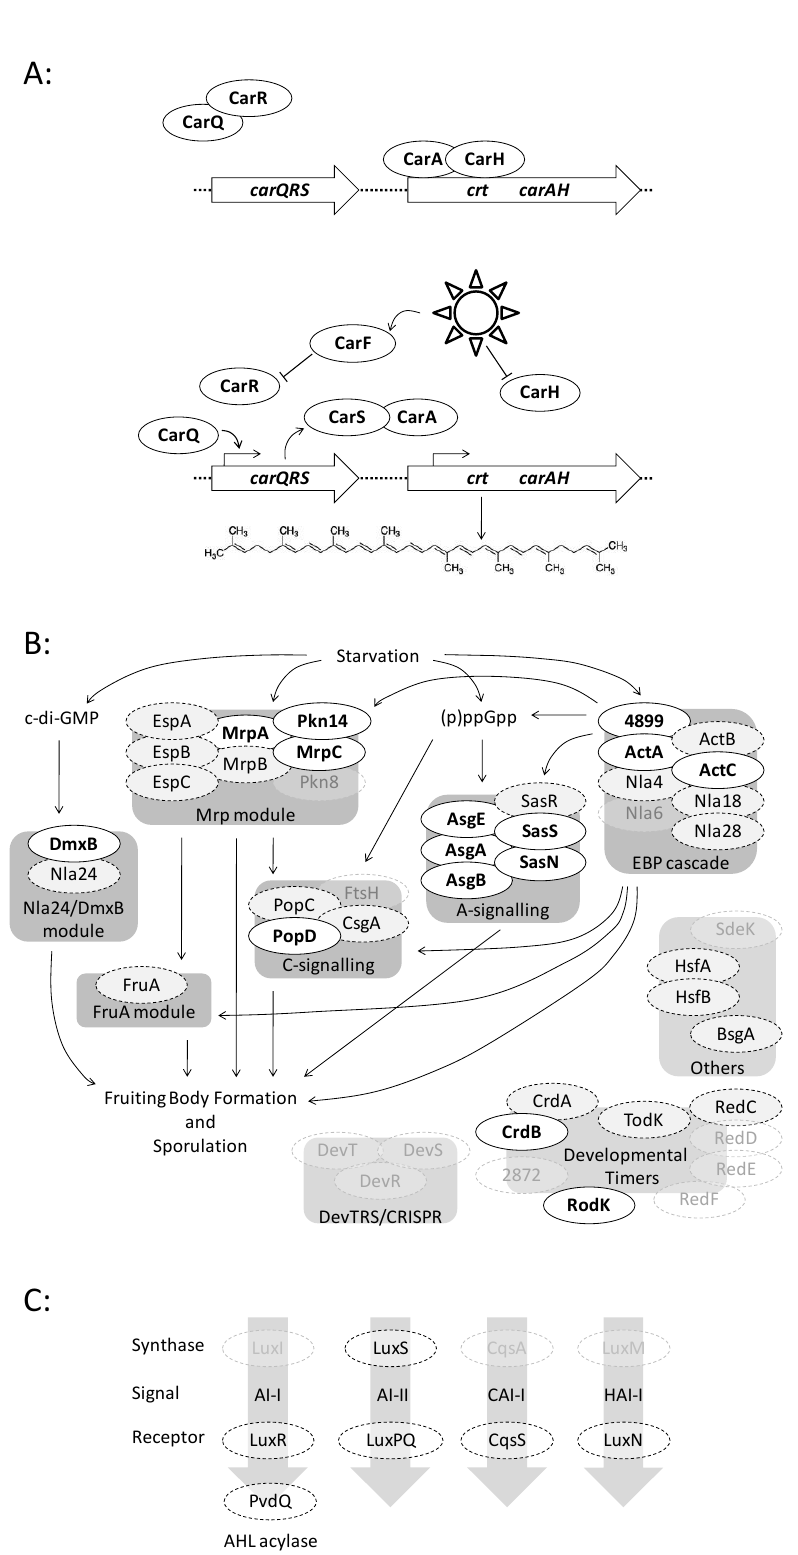
Figure 3. Conservation of signalling pathway proteins in Myxococcaceae. Regulatory proteins are shown as ovals. Positive regulation is shown with pointed arrows, and negative regulation with blunt-headed arrows. ( A ) Carotenoid production. In the dark (top), CarQ is held inactive by CarR, while CarA and CarH repress expression of the constitutively active crt promoter. In the light (bottom), CarH is directly inactivated while CarF inactivates CarR, releasing CarQ to direct transcription of carQRS , producing CarS which binds to CarA, relieving repression of the crt genes, which encode enzymes for the biosynthesis of carotenoids (lycopene shown as an example). ( B )